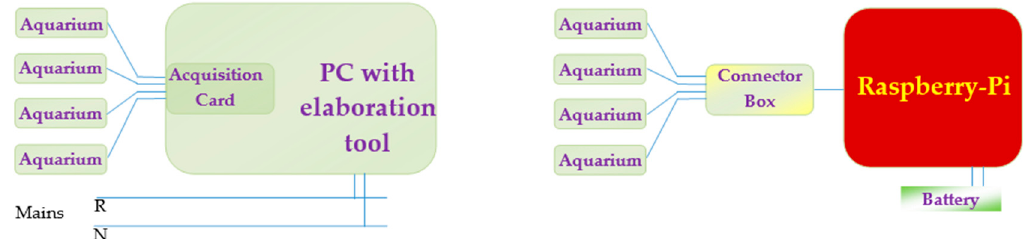
Figure 9. Classical and Raspberry-based architecture.